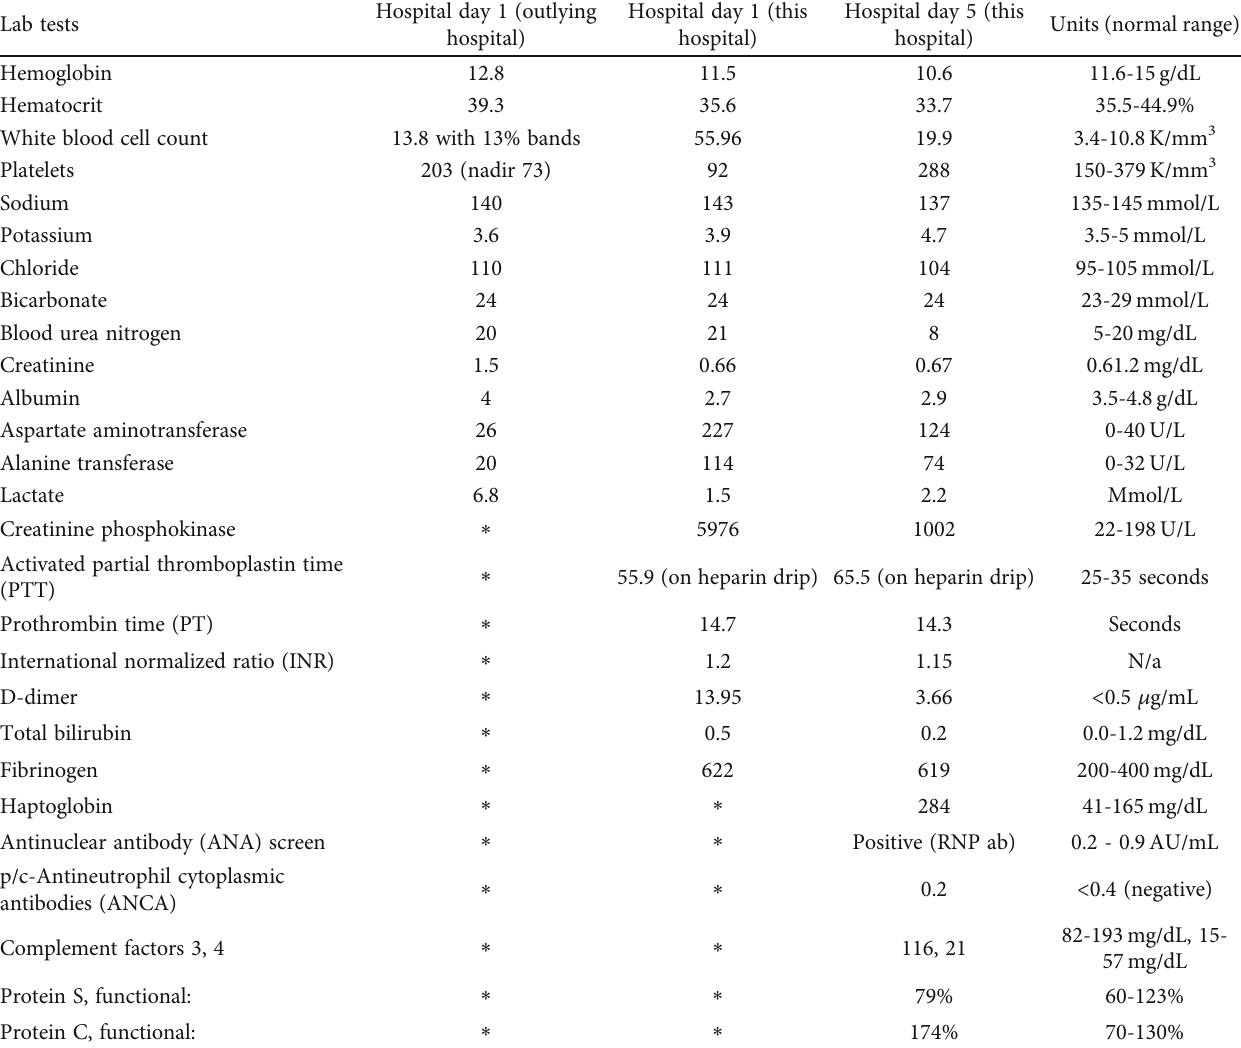
Table 1: Laboratory values upon initial presentation to our facility. Of note, patient remained on continuous heparin infusion during time of lab results.